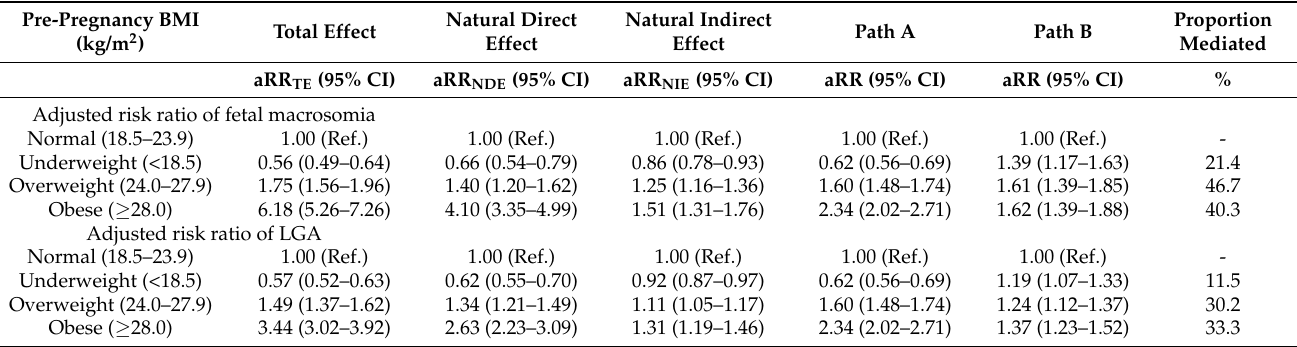
Table 3. The estimated total effect, natural direct effect, natural indirect effect, and Path A and Path B for the association of pre-pregnancy BMI on macrosomia and LGA births with GDM as a mediator using a log-binomial